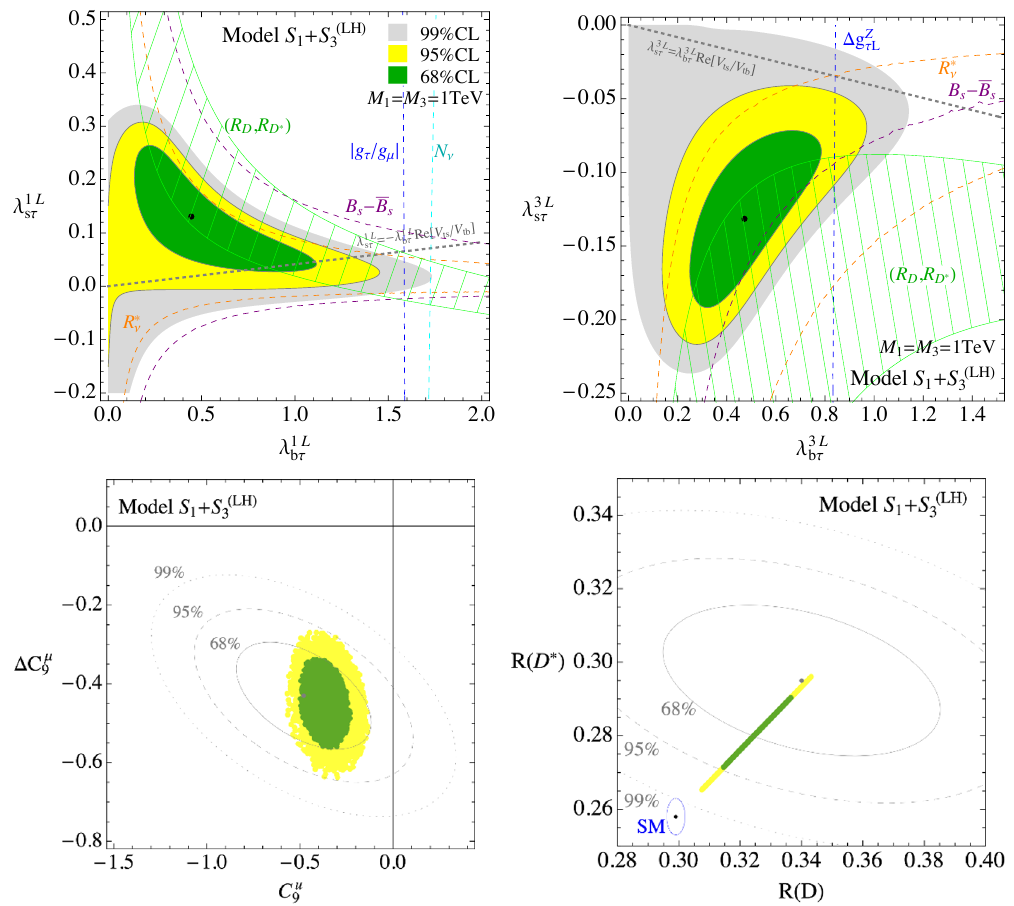
Figure 5 . Result from the fit in the S 1 + S 3 ( LH ) model, with only left-handed couplings. In the upper panels we show the preferred regions in the planes of two couplings, where the two not shown are profiled over. The dashed lines show, for illustrative purposes, 2 σ limits from individual observables where the other couplings are fixed at the best-fit point (black dot). In the lower panels we show where the preferred region is mapped in the planes of the neutral and charged-current